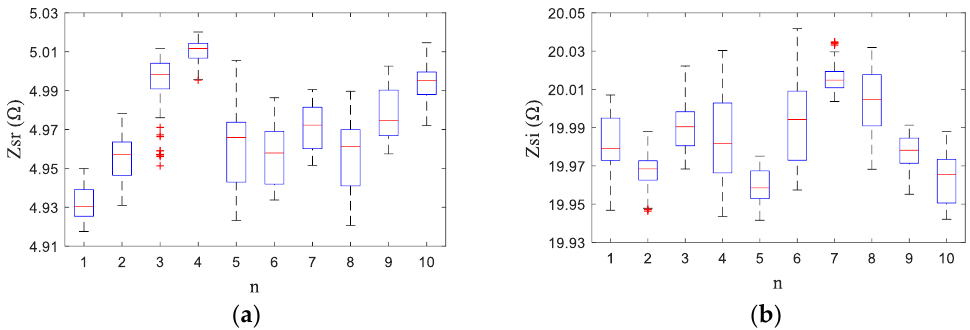
Figure 11. Results of method 3 in simulation II. ( a ) Result of real part; ( b ) Result of imaginary part.